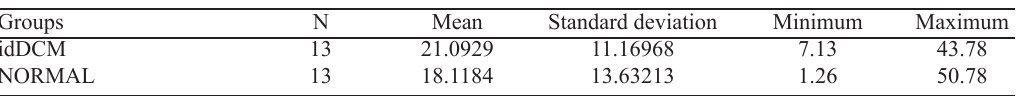
Table 8. Descriptive measures of variables of elastic fibers of LVR in idDCM and NORMAL groups (percentage).